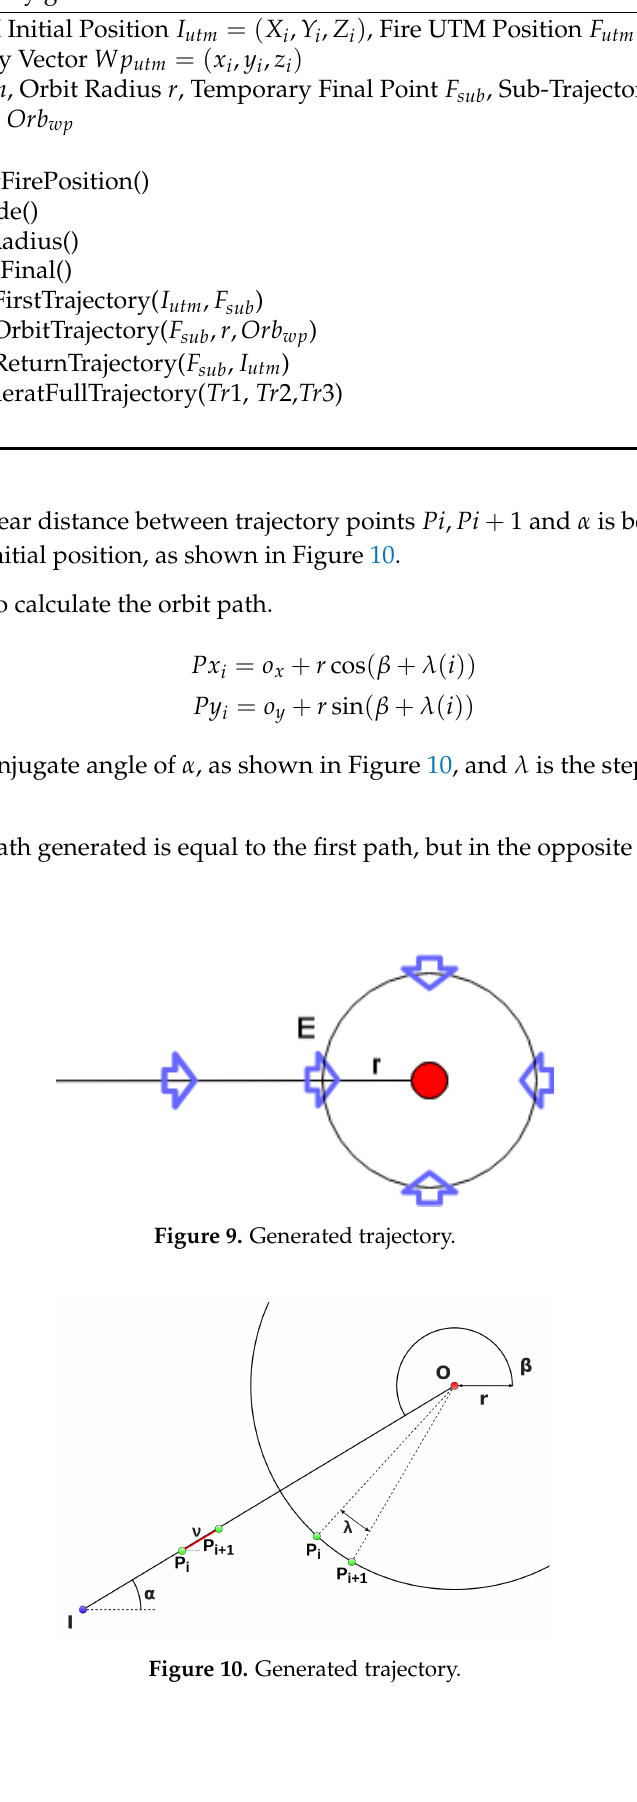
Algorithm 1: Trajectory generation.